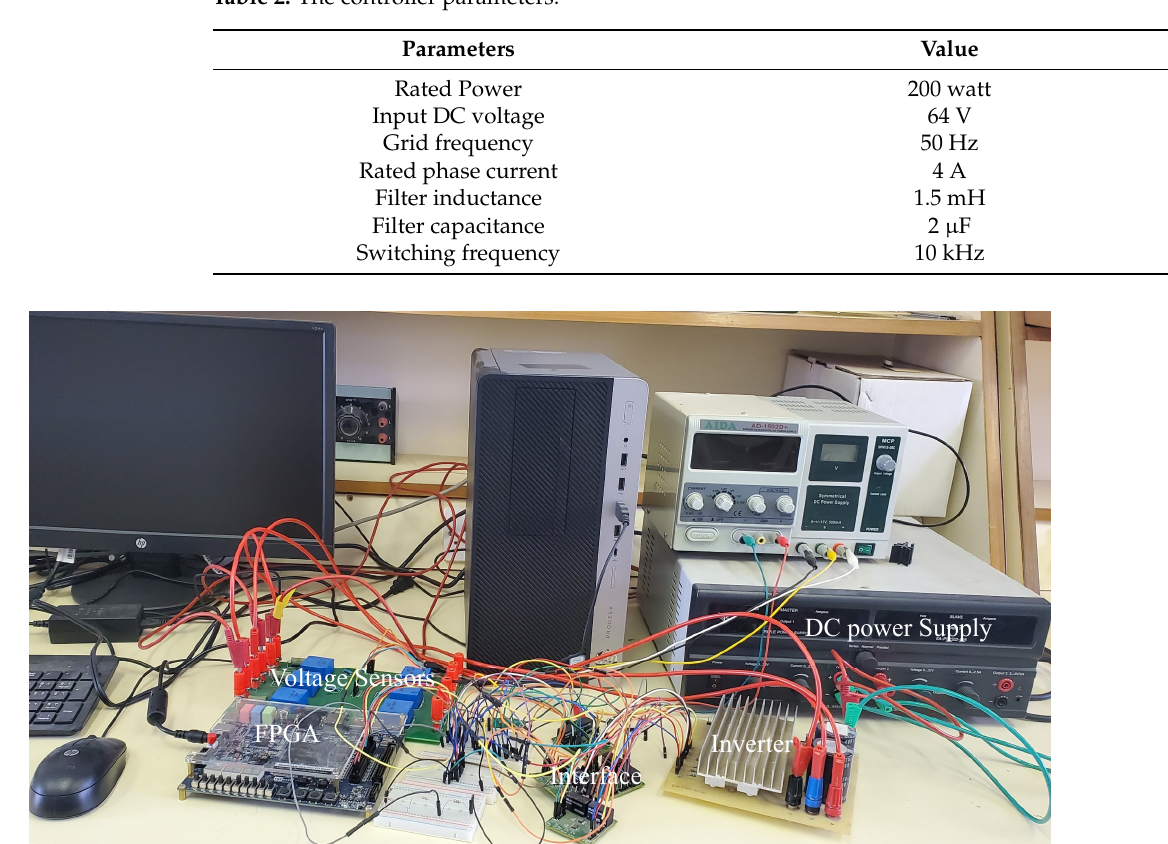
Figure 11. The hardware setup photo.